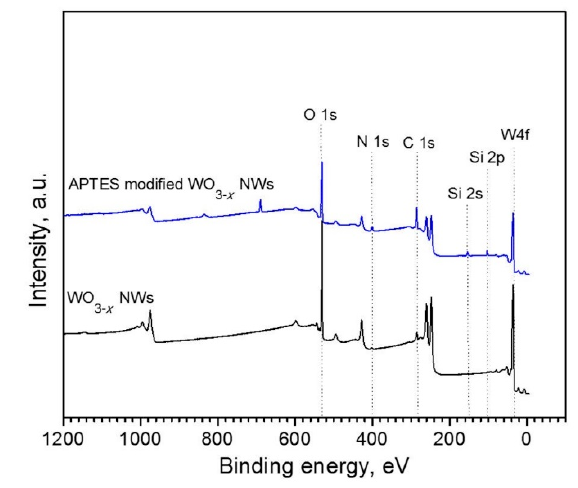
Figure 2. Survey XPS spectra for the APTES modified and non-modified WO 3 − x NWs (only the peaks of interested have been marked).